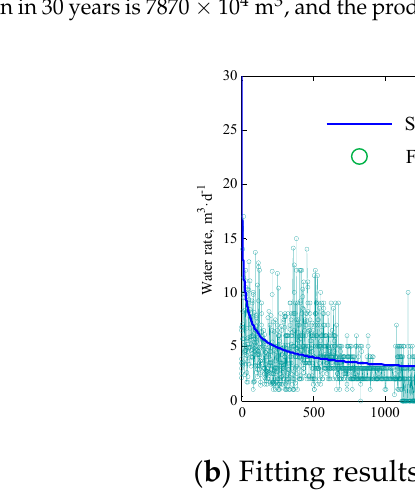
Table 3. Matching Interpretation Results of Example Wells.